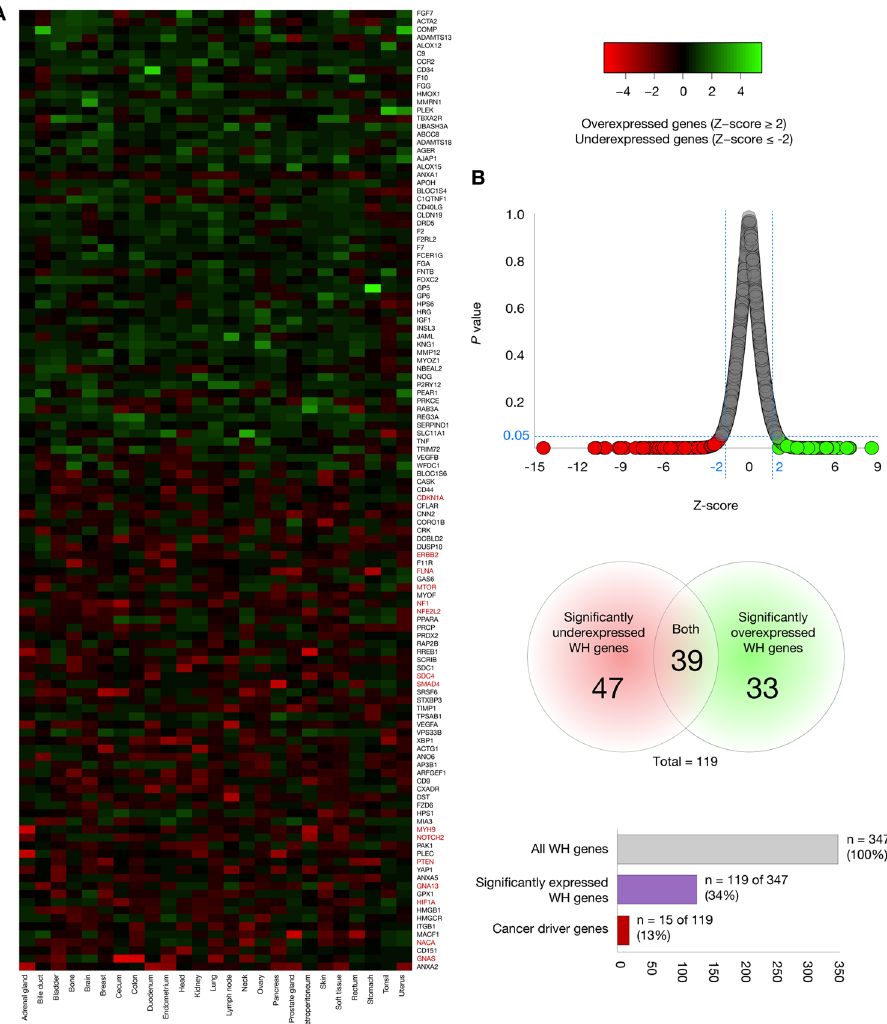
Figure 3. Patient-derived xenografts. ( A ) Heatmap of significantly overexpressed (Z-score ≥ 2) and underexpressed (Z-score ≤ 2) genes across 25 primary sites of tumor. ( B ) Plot of distribution of the transcriptional profile of WH genes considering their Z-scores and P -values per each cancer type. Lastly, the heatmap includes 15 cancer driver